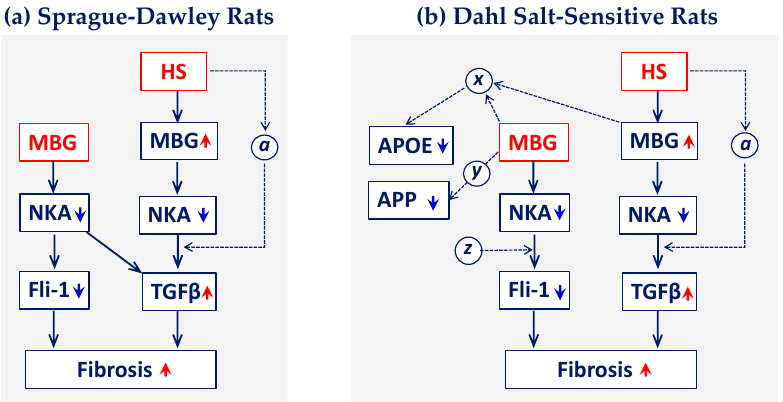
Figure 8. Schematic presentation of the MBG and HS effects on profibrotic signaling in Sprague– Dawley (SD) rats ( a ) and Dahl salt-sensitive (DSS) rats ( b ). HS diet had a similar effect on cardio- vascular fibrosis in SD and DSS rats with an activation of TGF β signaling, whereas MBG admin- istration had a different effect on the genes participating in profibrotic pathways. In SD rats, MBG activated both Fli-1 and TGF β dependent pathways, whereas in DSS rats, MBG activated only Fli1-dependent profibrotic signaling. In addition, MBG downregulated expression of APOE and APP genes in DSS rats. HS, high salt; MBG, marinobufagenin; NKA, Na/K-ATPase; Fli-1, Freund leukemia integration 1 transcription factor; TGF β , transforming growth factor beta; APOE, apoliporpotein E; APP, amyloid precursor protein; a , the factor which participates in the activation of TGF β pathway by an HS diet; x , the factor, which participates in APOE pathway downstream of MBG; y , the factor which participates in APP pathway downstream of MBG; z , the factor which participates in Fli-1 pathway activation and possibly blocks TGF β pathway. The hypothetical factors a , x , y and z require additional investigation; factor a may be present in both SD and DSS rats, and it is regu- lated by HS intake; factors x , y and z may be activated by MBG in DS rats.